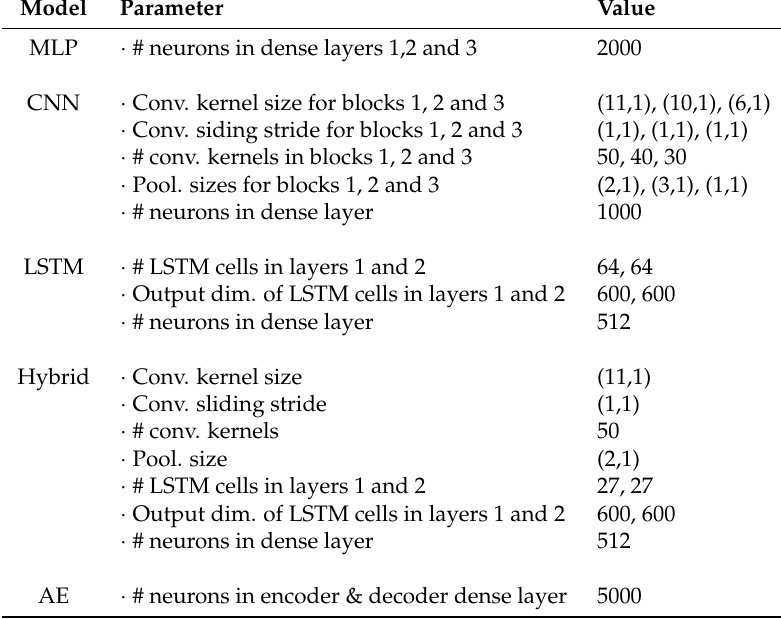
Table 3. Hyper-parameters of the deep-learning-based models found for T = 64 on the OPPORTUNITY dataset. The parameters values are given assuming that the input of the models is of size T × S . Convolutional kernels and pooling sizes are, respectively, given as ( f their definition in Section